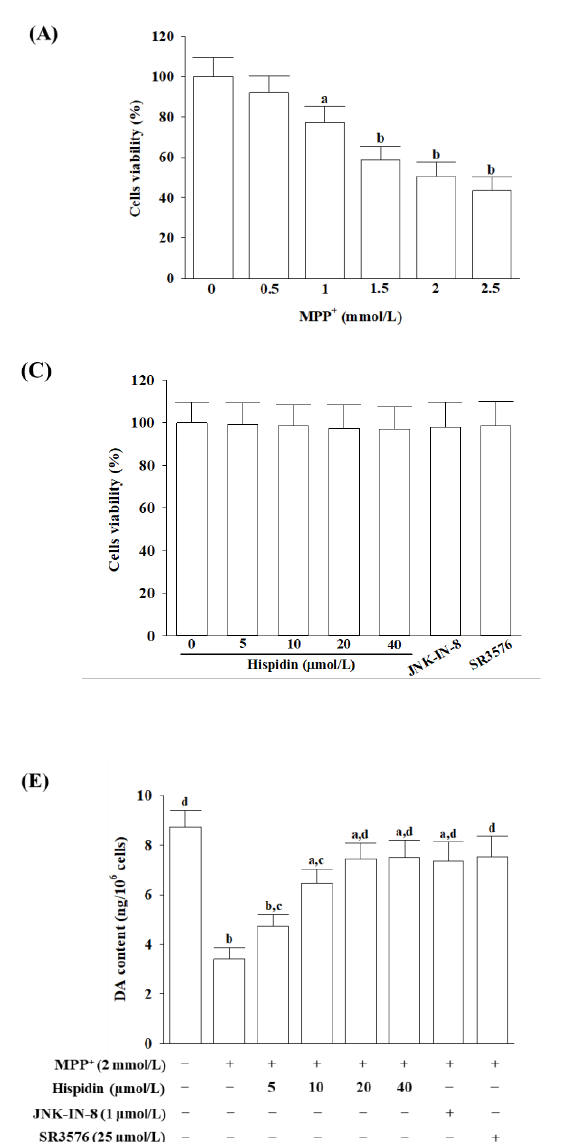
Figure 1. Hispidin alleviates MPP + -induced loss of cell viability and DA content in MES23.5 cells. ( A ) Cell viability was assessed for MES23.5 cells incubated with increasing concentrations of MPP + over 24 h. ( B ) Cell viability was evaluated for MES23.5 cells incubated with 2 mmol/L MPP + over a given period. ( C ) Cell viability was evaluated when MES23.5 cells without stimulation of 2 mmol/L MPP + instead of 24-h incubation at various concentrations of hispidin, JNK-IN-8 (1 µ mol/L), or SR3576 (25 µ mol/L). ( D ) Cell viability and ( E ) dopamine (DA) content was evaluated when MES23.5 cells received 1 h pretreatment with hispidin at different concentrations, JNK-IN-8 (1 µ mol/L) or SR3576 (25 µ mol/L), and following received 2 mmol/L MPP + exposure for another 24 h. Cell viability was determined with a CCK-8 assay and expressed as a percentage of untreated cells taken as a control group. DA content as determined by HPLC assay. The results are shown as the mean ± SD of five independent experiments ( n = 5) performed in triplicate. a p < 0.05 and b p < 0.01 compared to the untreated control group. c p < 0.05 and d p < 0.01 compared to the untreated MPP +